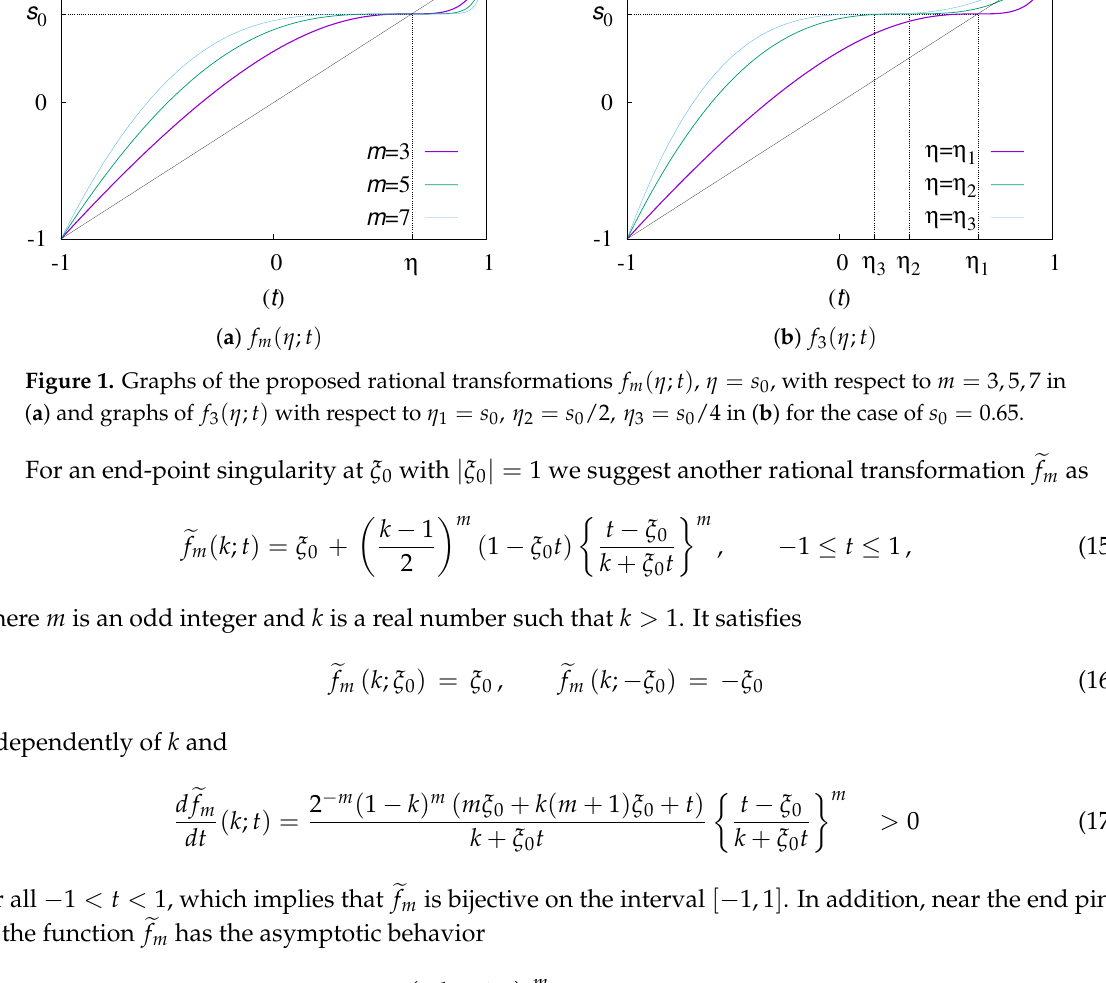
. Setting x = f m ( η ; t ) in (1) and (2), we have the 17 (cid:16) (cid:17) (cid:0) ( ( t − η ) ( α + 1 ) m − 1 t − η ) m − 1 log | t − η | and O